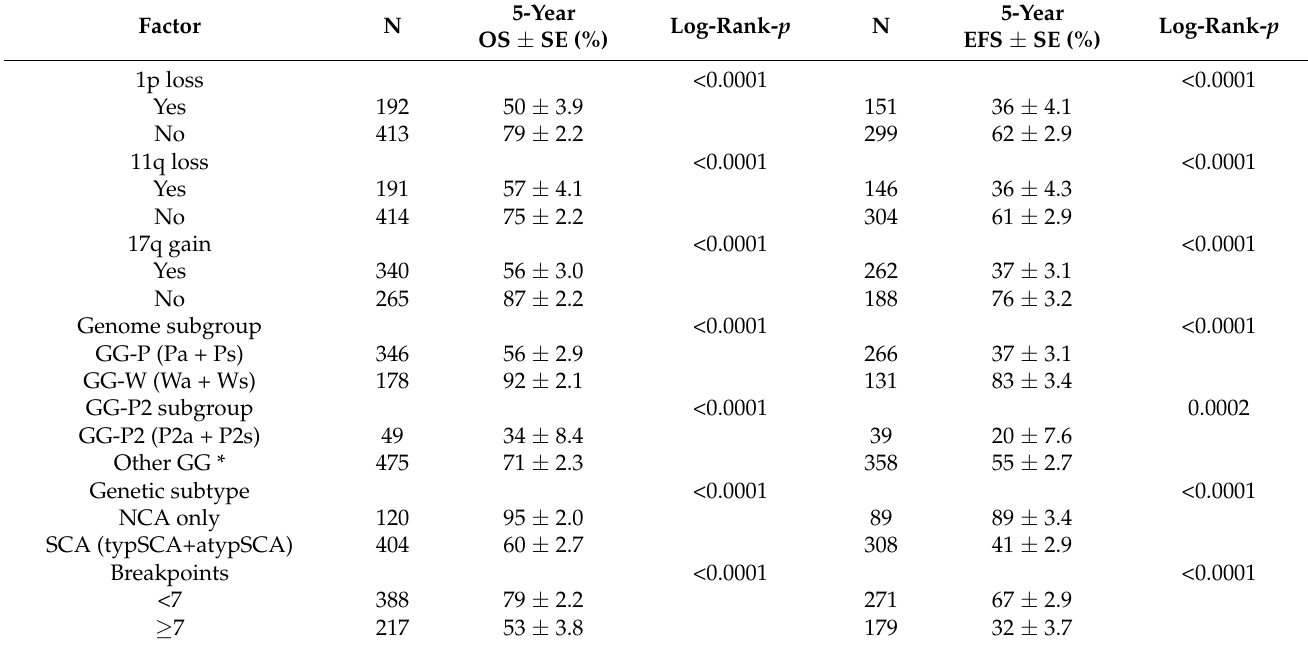
Table 2. Genomic characteristics of 605 JPN patients (5-year overall and event-free survival